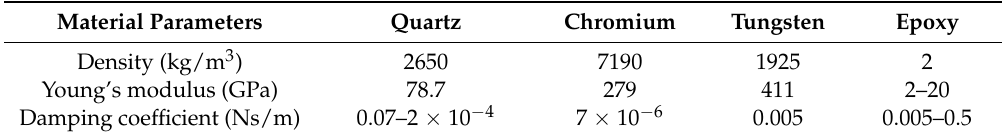
Table 1. Material parameters of the QTF and probe.